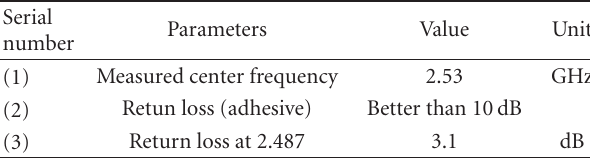
Table 3: Measurement of 2.487 GHz